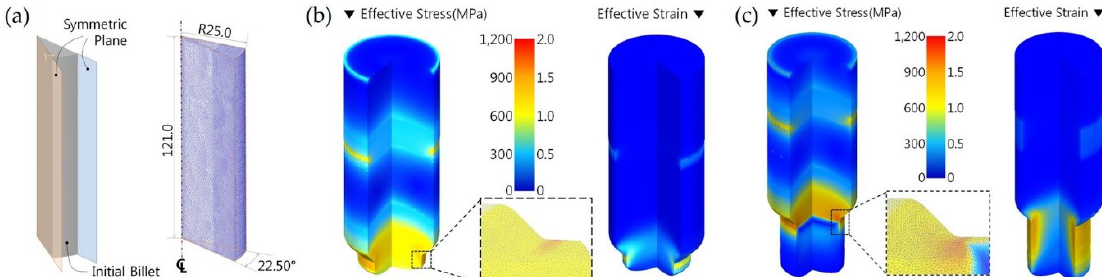
Figure 6. Effective stress and strain distributions obtained from forward extrusion simulation for preform forging: ( a ) Symmetric condition and initial mesh structure with 257,678 tetrahedral elements for preform forging; ( b ) Effective stress and strain distribution at punch stroke of about 53%; ( c ) Effective stress and strain distribution at punch stroke of 100%.